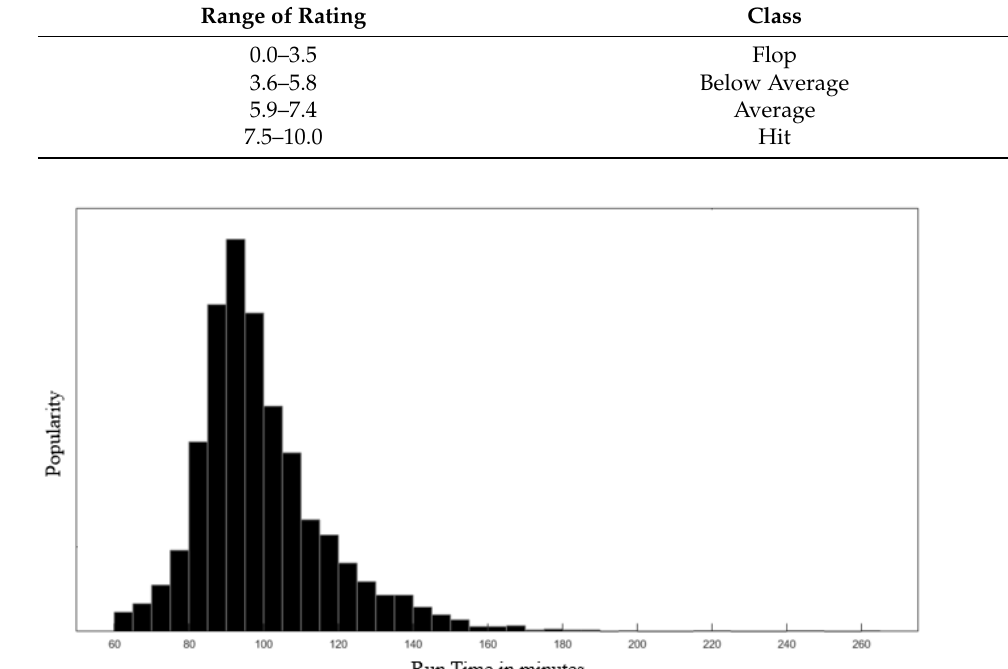
Table 2. Rating Classification.